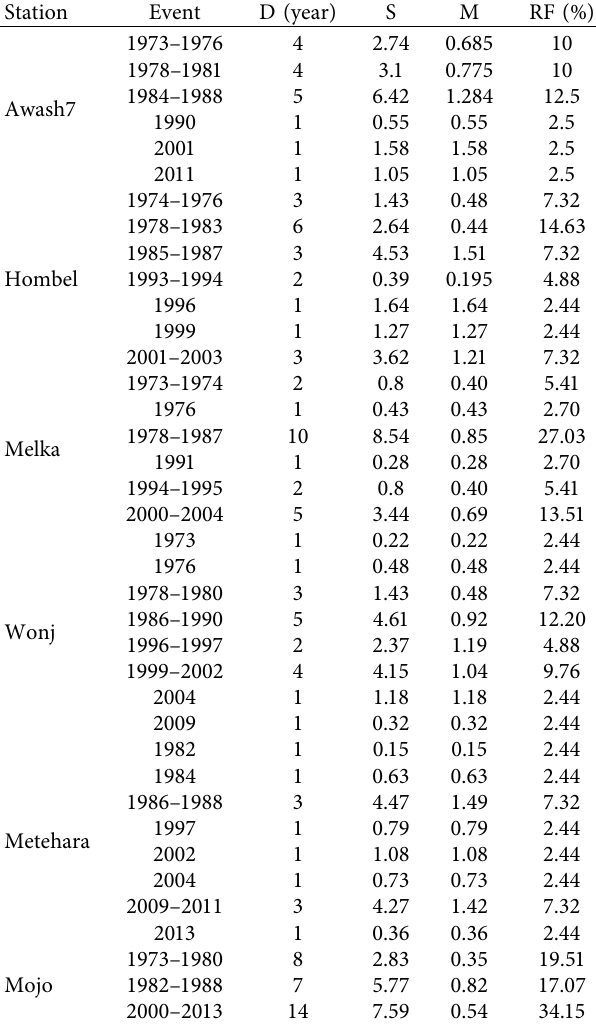
Table 9: Hydrological drought characterization in Ethiopian major river basins, Baro Akobo river basin. Station